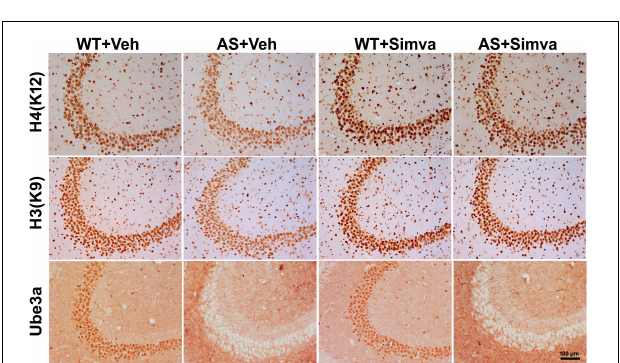
FIGURE 6 | Representative immunohistochemical staining of acetylated histones H3(K9) and H4(K12) in the hippocampal CA3 region of wild type and AS mice received simvastatin or vehicle. Brain sections (20 µ m thickness) collected from all four different groups of mice were placed on the same slide and processed for immunostaining of H3(K9), H4(K12) and Ube3a. Sections from four different mice in each experimental group were evaluated. Hippocampal CA3 area is shown in the image. Scale bar, 100 µ